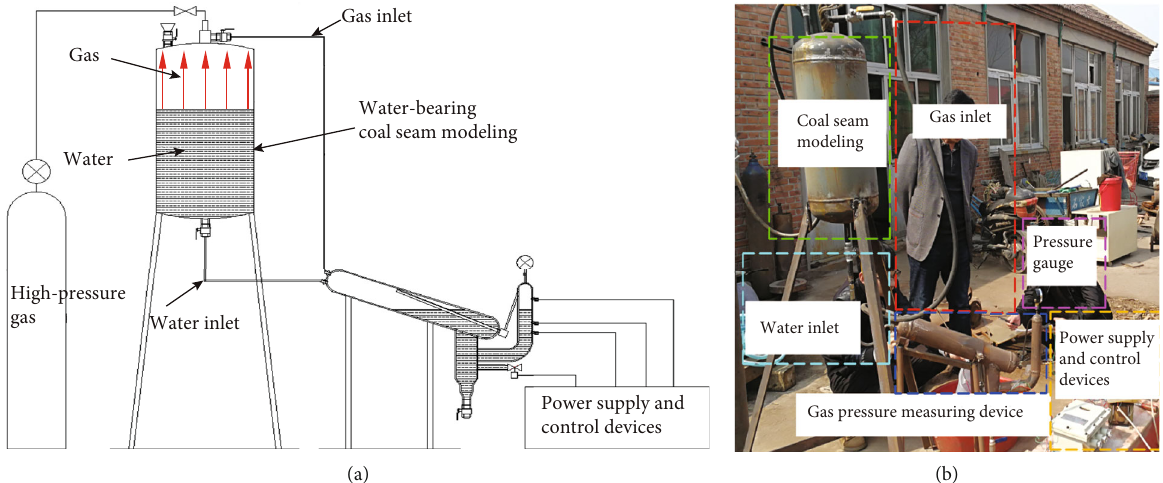
Figure 4: Gas pressure simulation testing in water-bearing coal seams: (a) experimental schematic diagram and (b) fi eld test.